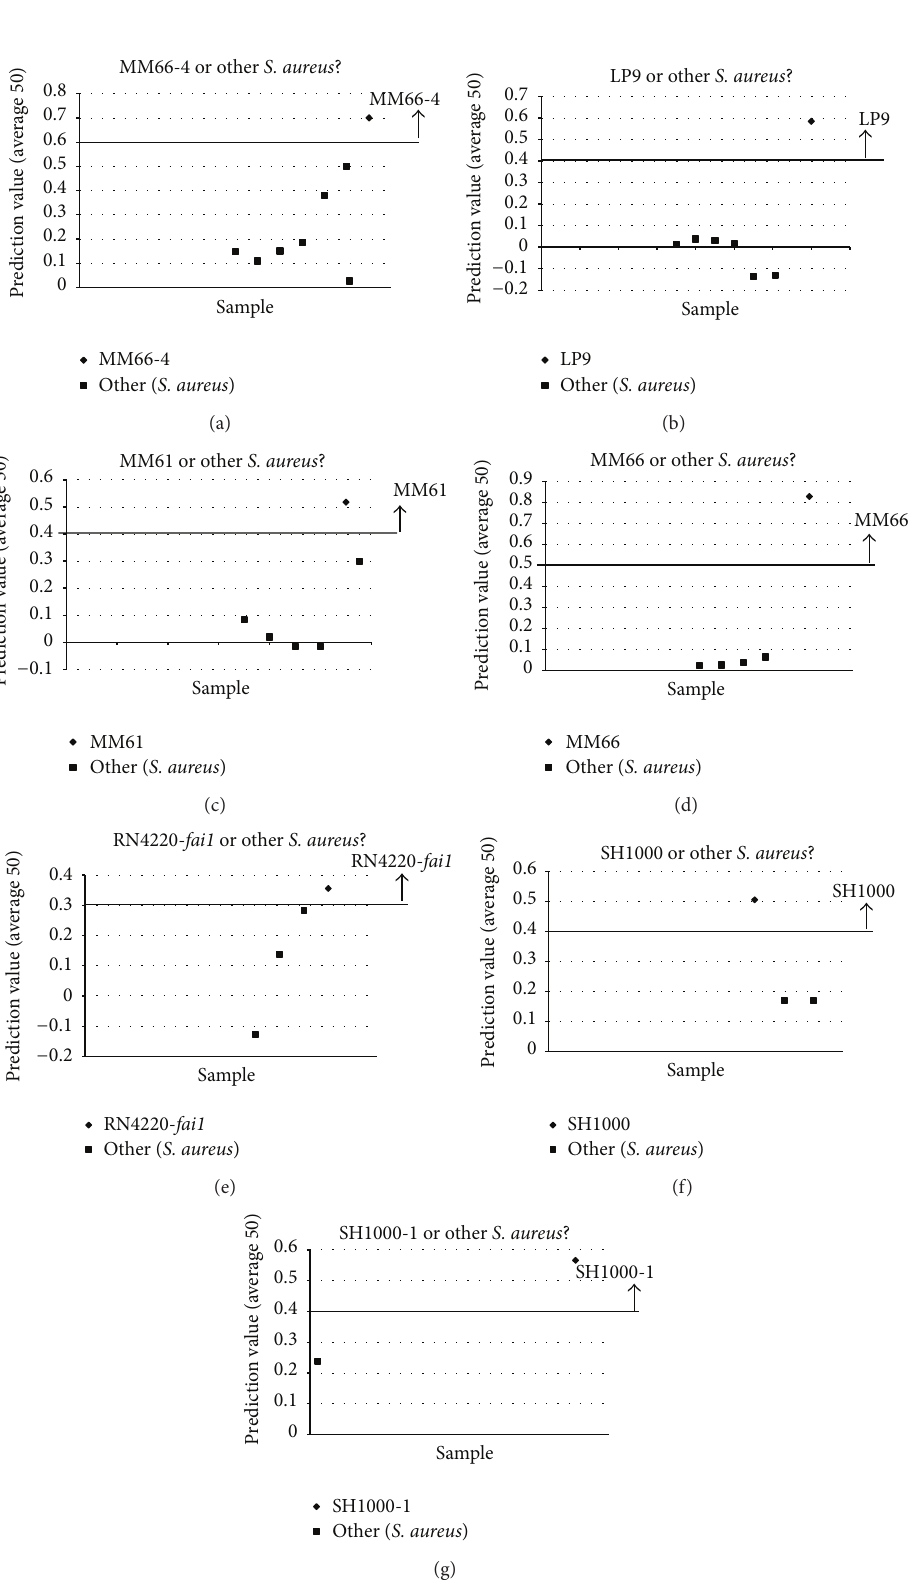
Figure 6: Plots of the prediction values obtained when discrimination models in the S. aureus branch of the discrimination algorithm were tested using the verification